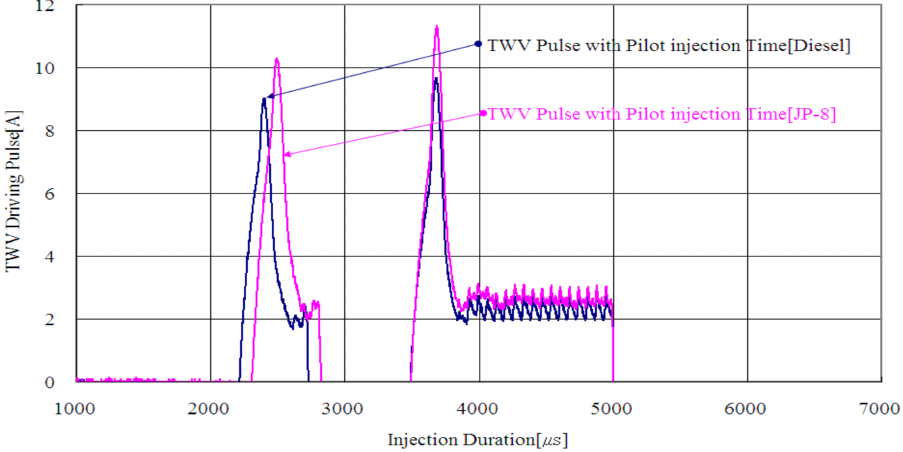
Figure 4. Signal for injection of JP-8 and diesel with pilot injection.